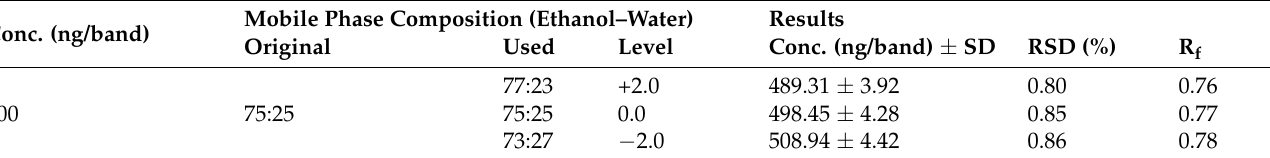
Table 5. Measurement of CDN robustness for current protocol (mean ± SD; n = 6).